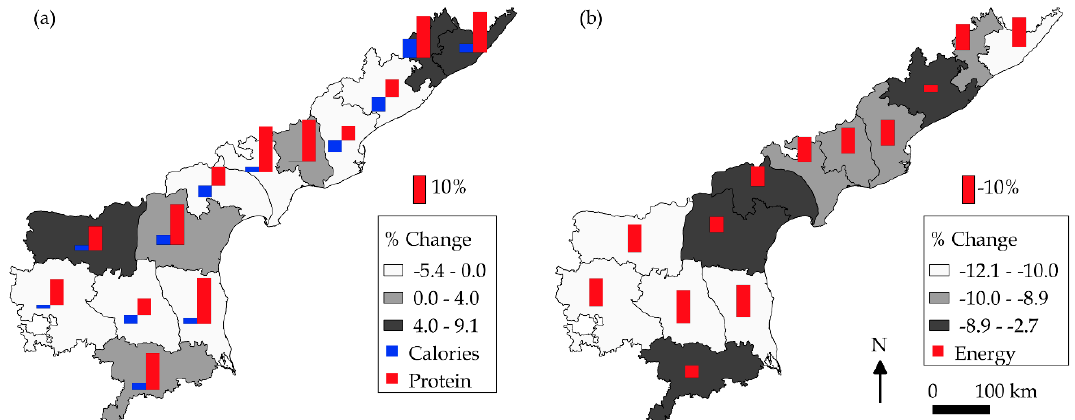
Figure 4. Spatial distribution of the impact of crop diversification across the study area for Scenario B (strategy 5). The values plotted are the percentage change compared to the base case: ( a ) Food production (the bar charts represent the corresponding changes in calories and protein production); ( b ) Groundwater consumption (the bar chart represents the changes in energy consumption).